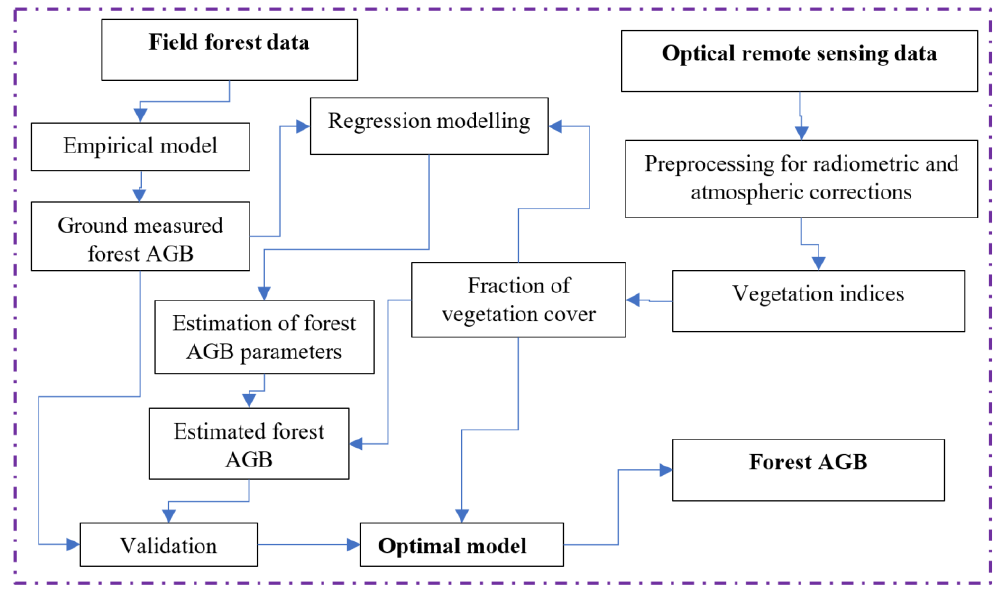
Figure 2. Flow diagram of the proposed methodology.